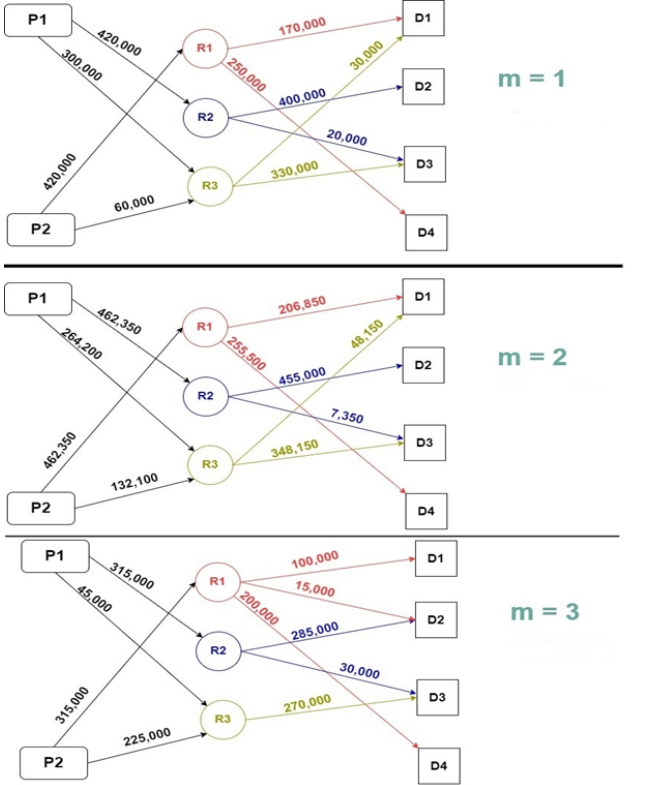
Figure 2. Optimal network diagram representation of the quantity distribution (forward SC).